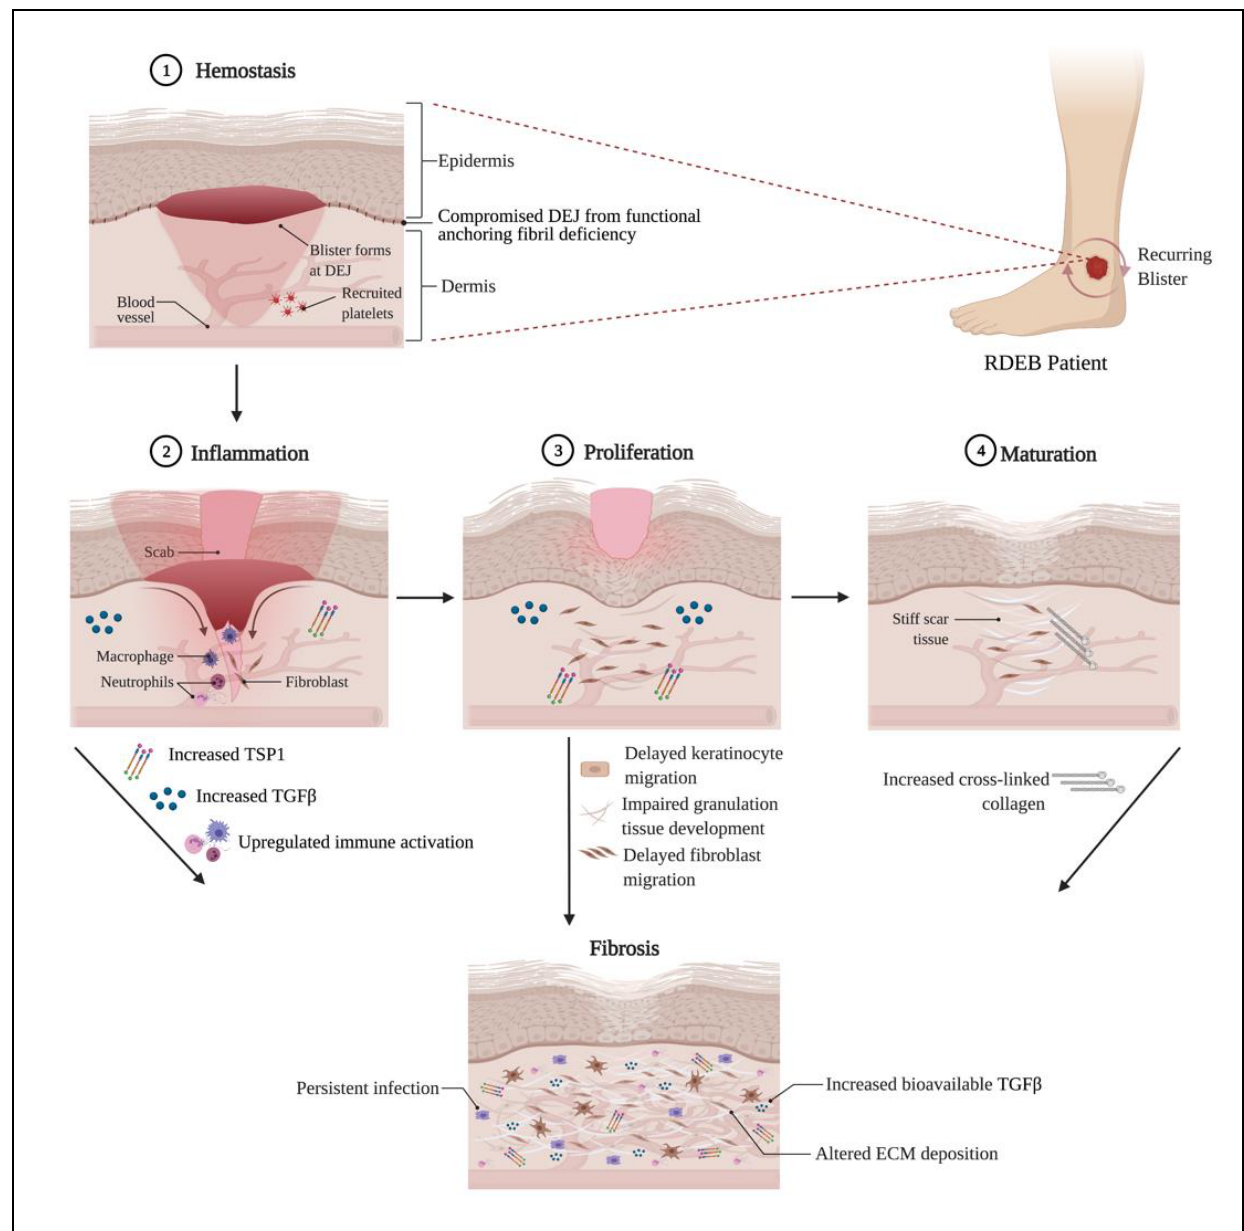
Figure 1. Wound Healing Complications in RDEB. A schematic showing the process of wound healing in its four stages: hemostasis, inflammation, proliferation, and maturation. In RDEB, blister formation triggers the wound healing cascade, which contributes to the increased expression of TGF β and TSP1, among others. Excessive amounts of these factors contribute to delays in keratinocyte and fibroblast migration, slowing down wound closure. There can also be a persistent infection in the wound area, denoted by the increased presence of activated immune cells. In the event of unresolved maturation, fibrosis occurs, which is demarked by altered ECM deposition. Crosslinked collagen in the wound bed is a prominent component of excessive ECM deposition, leading to the heavy scarring phenotype. Created with Biorender.com.